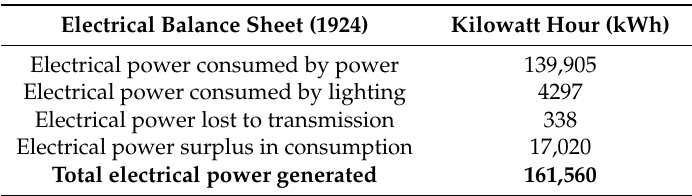
Table 1. Enugu electrical balance sheet 1924 [22].